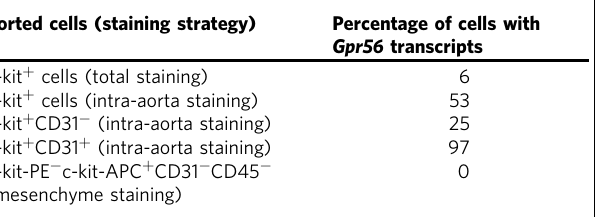
Table 1 Percentages of IAHC cells (identi fi ed by Gpr56 expression) after different antibody staining and cell sorting strategies Sorted cells (staining strategy) Percentage of cells with Gpr56 transcripts